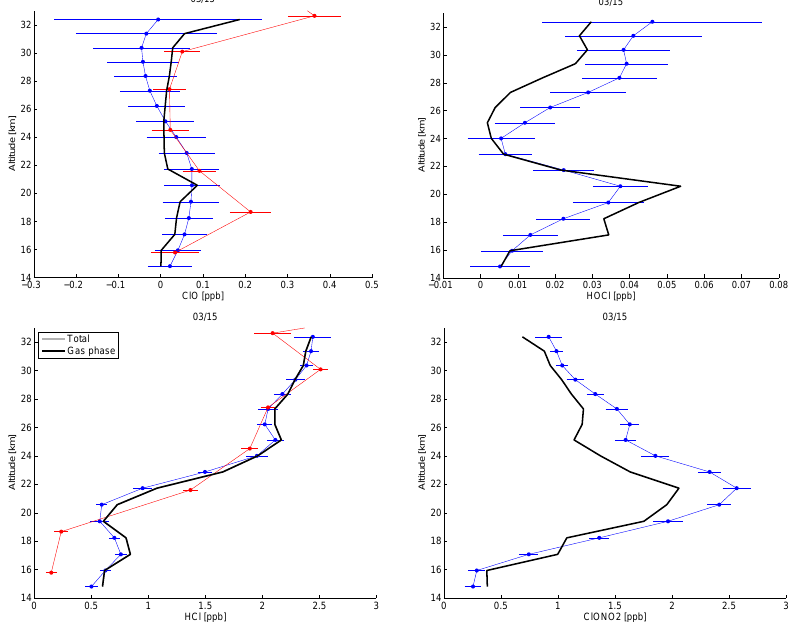
Fig. 9. ClO and its reservoirs HOCl, HCl and ClONO 2 from data of the OMS balloon launch on 15 March 2000. Measurements of the Mark IV instrument (blue, with error bars), the SLS instrument (red) and modeled values (black lines) are shown for comparison. Note that Mark IV and SLS are remote sensing instruments viewing into opposite directions and that the mixing ratios of the species are interpolated to the Mark IV tangent